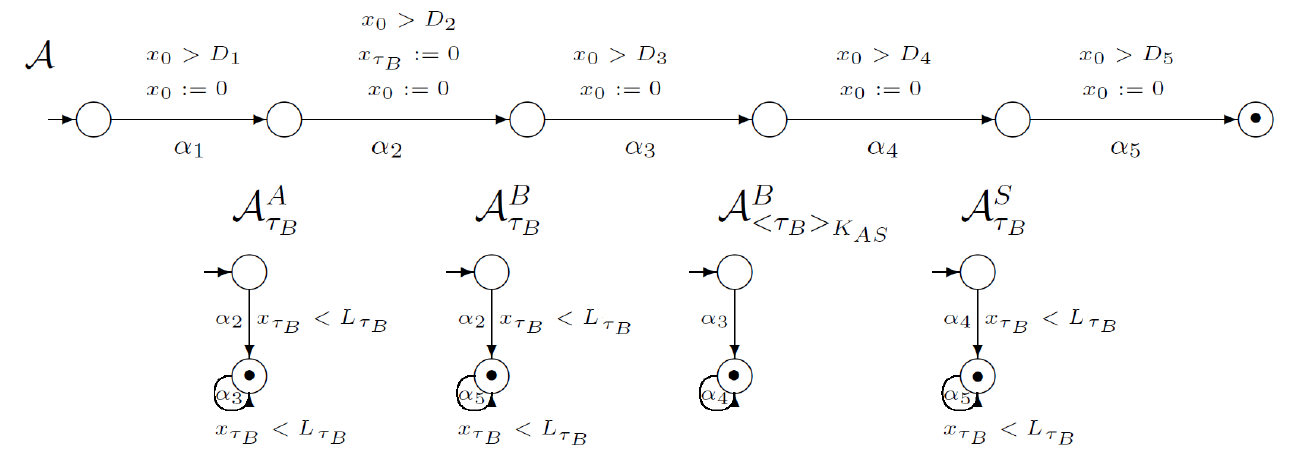
Figure 6. The fifth step of the WooLamPi